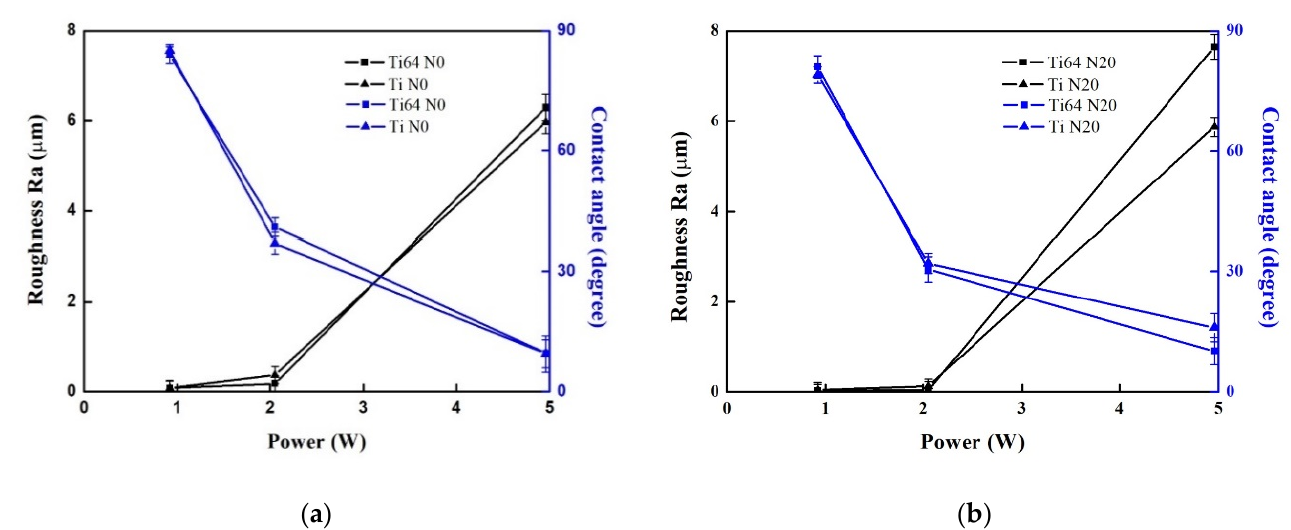
Figure 6. The roughness and contact angle of the CP-Ti and Ti64 samples for ( a ) N0 and ( b ) N20 after laser surface modification in an air atmosphere.